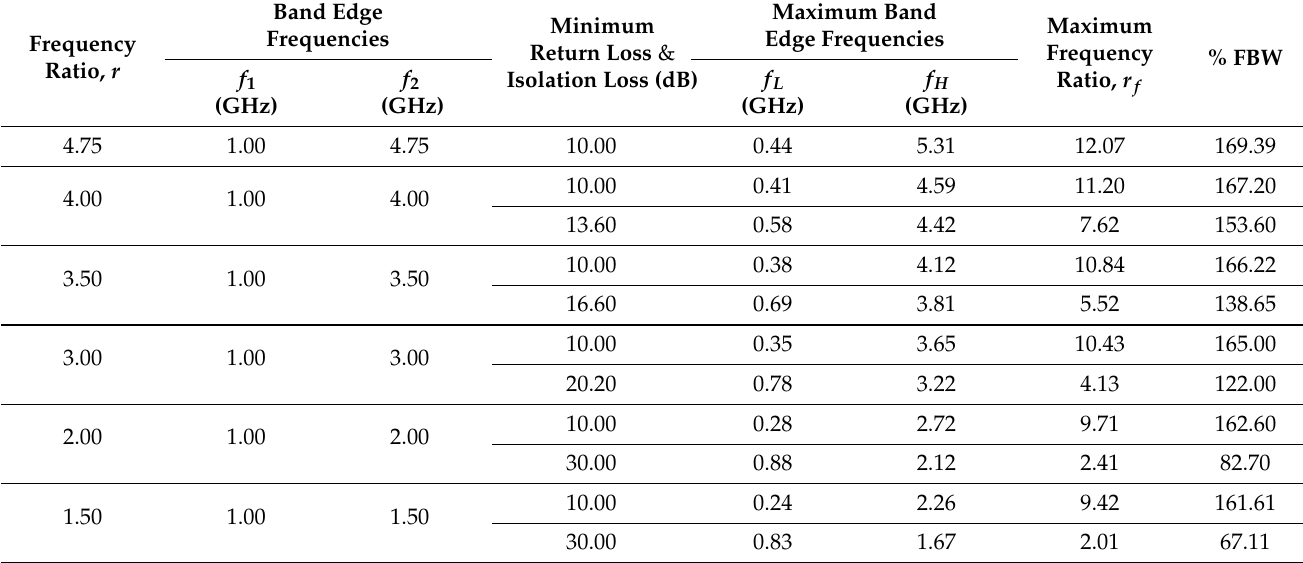
( c ) Ideal S-parameters for r = 3. Figure 4. Ideal S-parameters with variation of the frequency ratio. Table 1. Realizable frequency